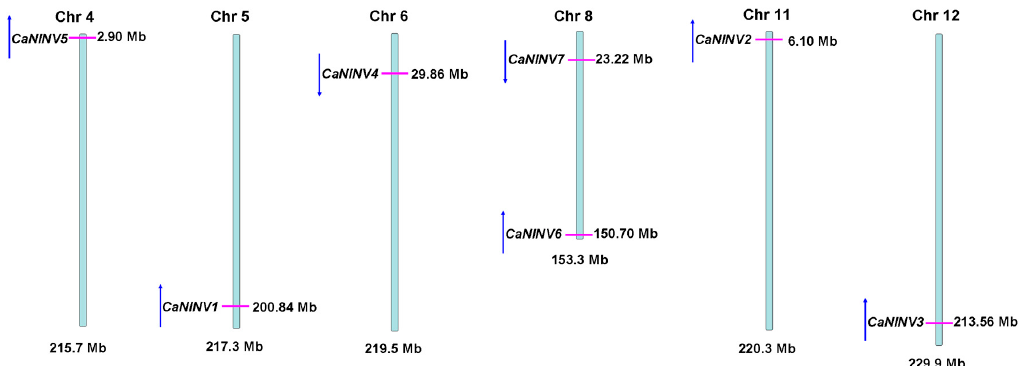
Figure 4. Chromosome localization of CaNINV genes from pepper. The positions of the CaNINV genes are shown as red lines. The genes orientation is shown as blue arrows.